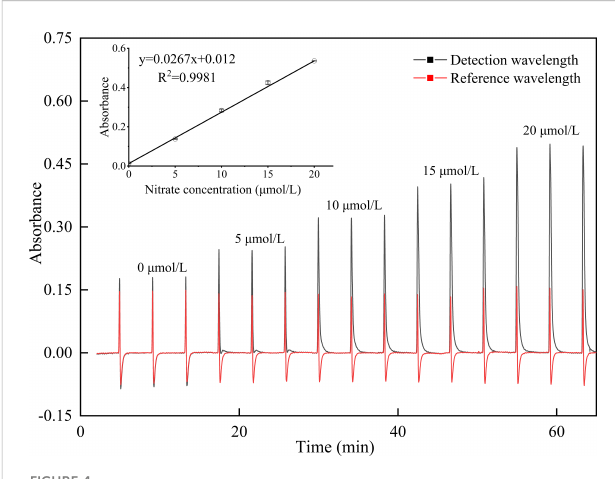
FIGURE 4 Typical output signals of the calibration curve ranging from 0 to 20 m mol/L for nitrate determination ( n = 3), where the inset shows the calibration